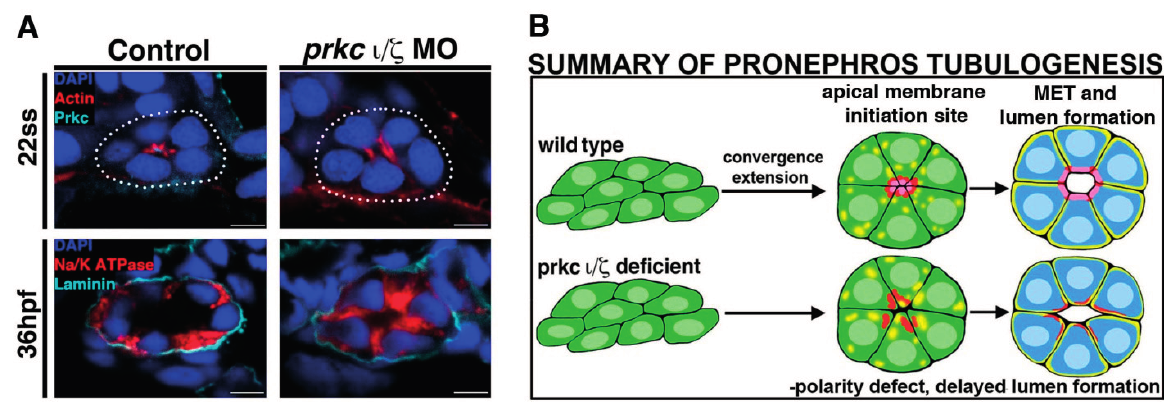
Figure 3. Deficiency of Prkc ι / ξ disrupts nephron epithelial polarity. ( A ) At the 22 ss, actin is mislocalized in Prkc ι / ξ deficient embryos, though lumen formation eventually occurs by